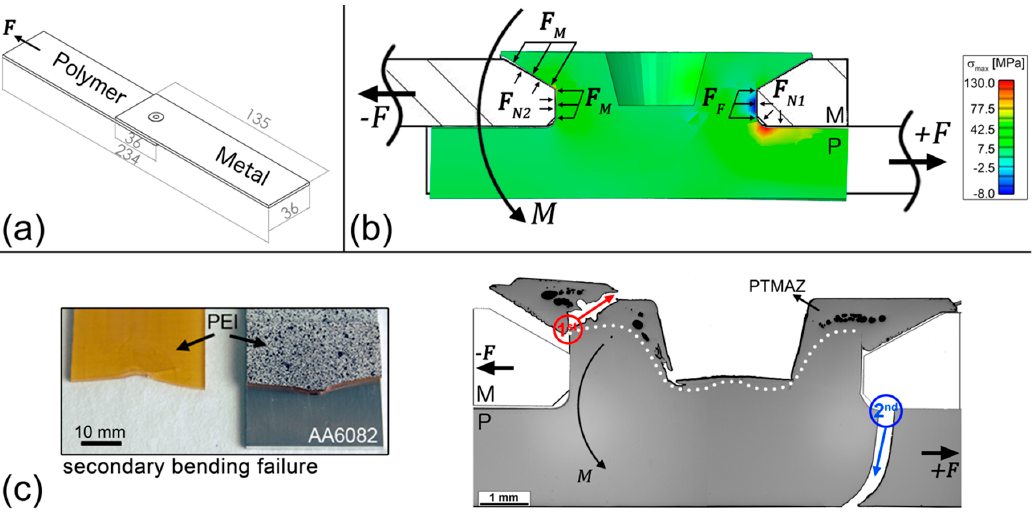
Figure 11. ( a ) Specimen and forces configuration for lap shear tests. ( b ) Stress concentration regions